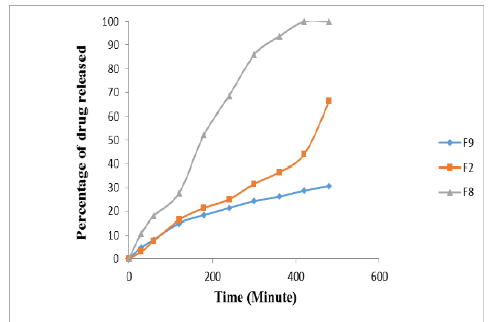
Figure 6. Effect of drug: polymer ratio on % drug release from F2, F8 and F